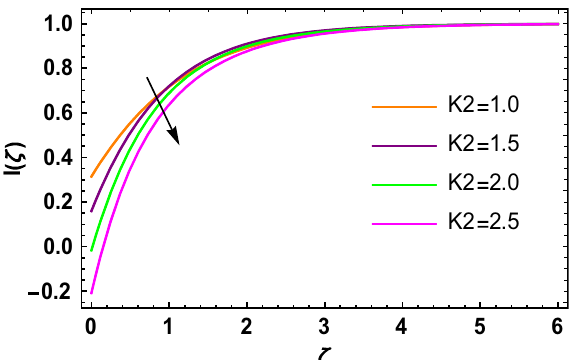
Figure 8. I (ζ) versus K 2 .